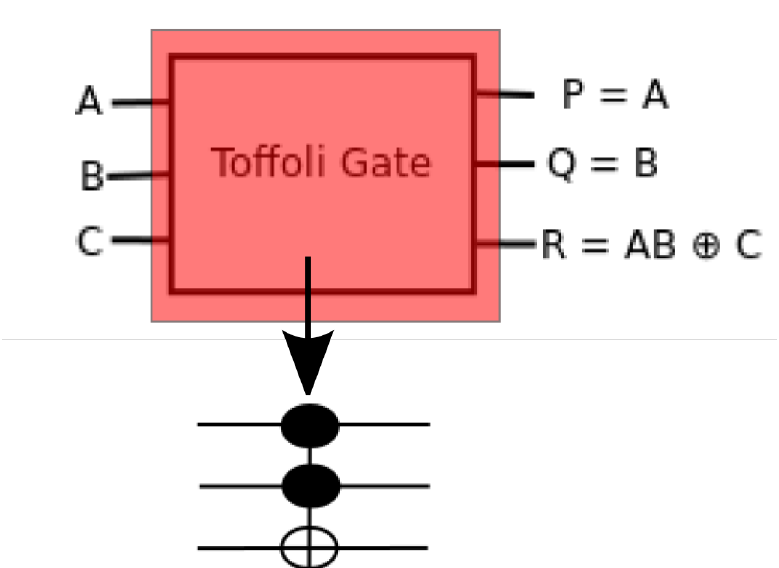
Figure 1. Toffoli gate: block and schematic representations where ⊕ represents the target line and • represents the control lines.